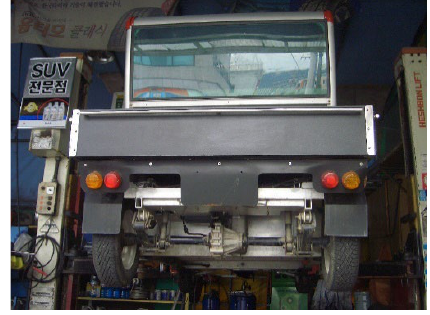
Figure 20. Actual vehicle installation.